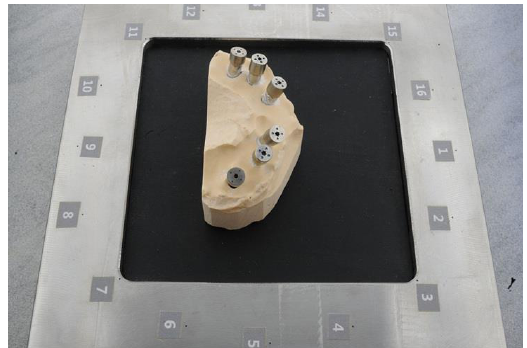
Figure 6. The steel plate with the 16 holes drilled by the numerically controlled machine and a master with the